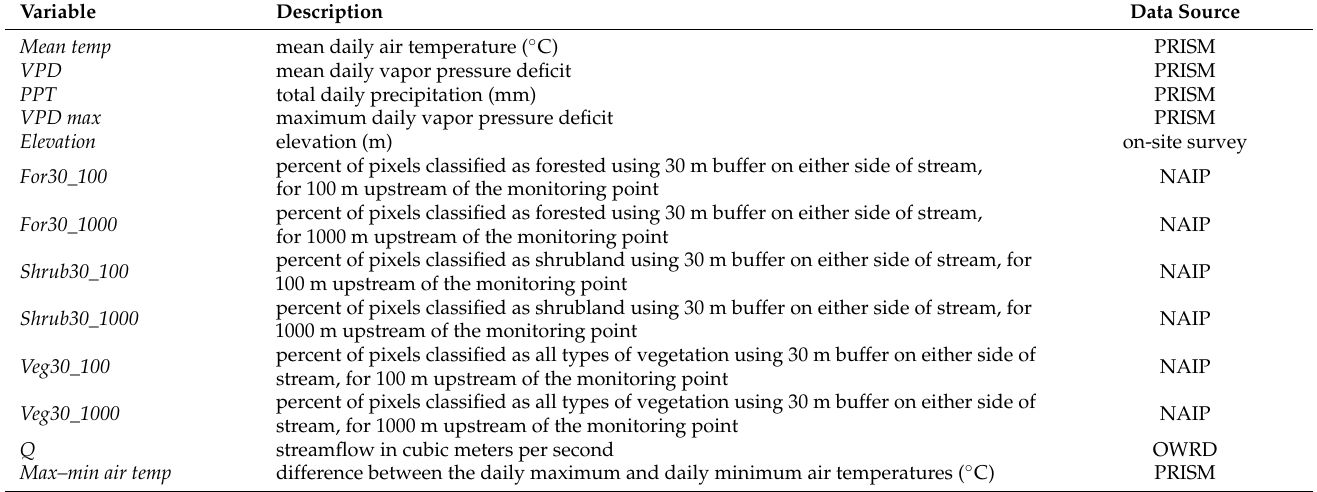
Table 1. Environmental variables used in the SVR model. The data source of each variable is listed in the third column. PRISM refers to Parameter-elevation Regressions on Independent Slopes Model (available at https://prism.oregonstate. edu/, accessed on 1 March 2019), NAIP refers to United States Department of Agriculture National Agricultural Imagery Program (available at https://earthexplorer.usgs.gov/, accessed on 16 January 2020) and OWRD refers to the Oregon Water Resources Department hydrographics data (available at https://apps.wrd.state.or.us/apps/sw/hydro_near_real_time/ Default.aspx, accessed on 5 April